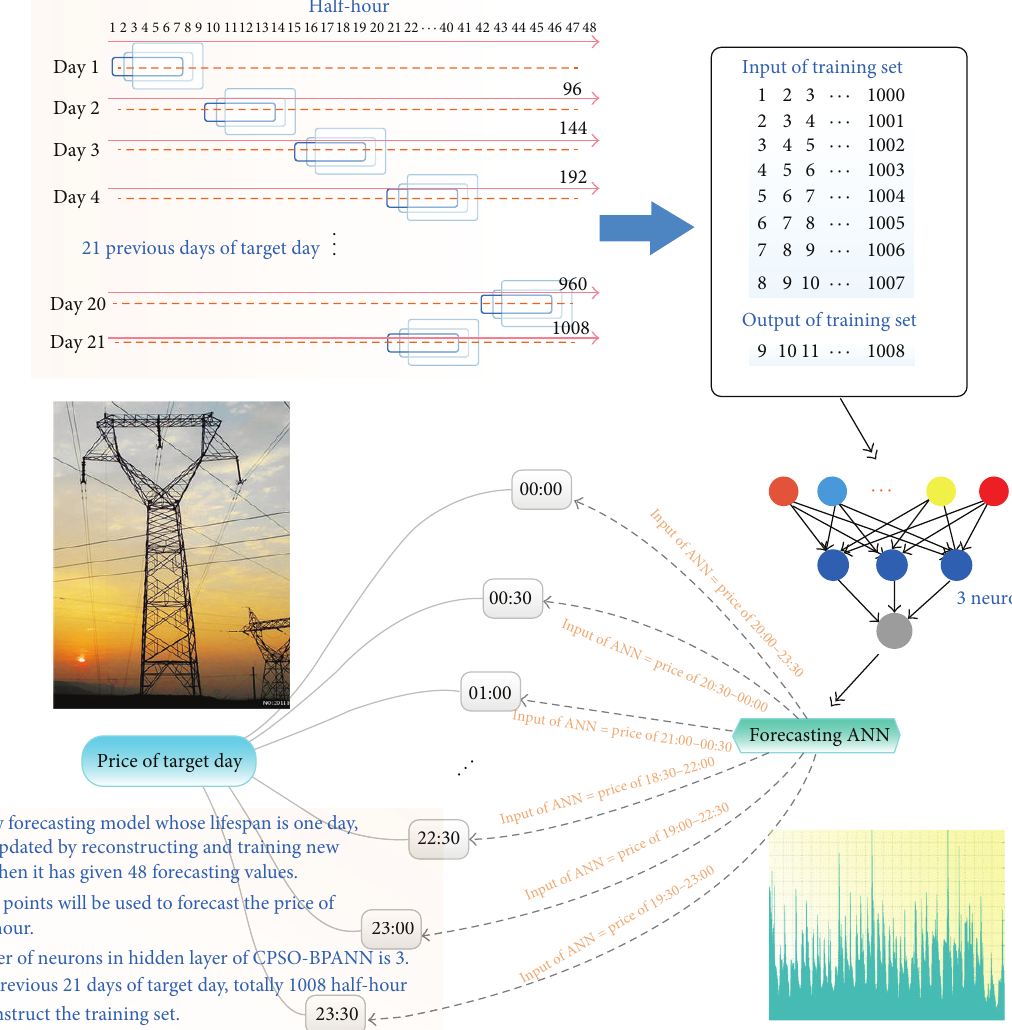
Figure 5: Forecasting Principles